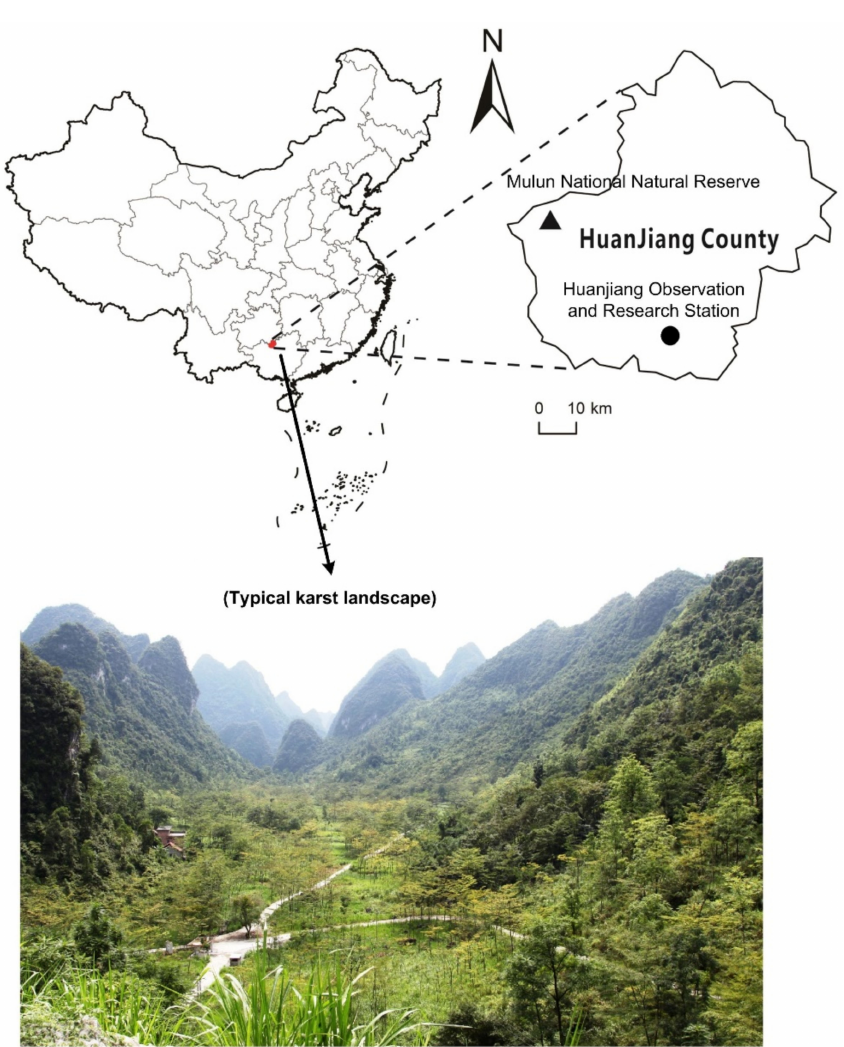
Figure 1. Sketch map showing the Huanjiang Observation and Research Station ( ) and Mulun National Natural Reserve ( (cid:78) ) and the typical landscape in a karst ecosystem of southwest